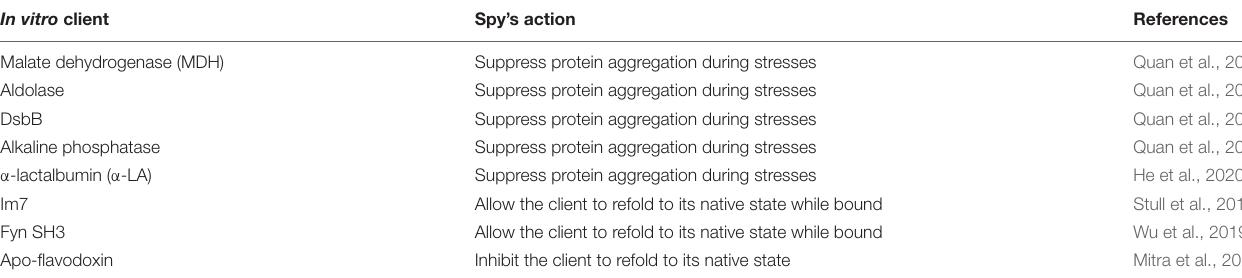
TABLE 1 | Various chaperone actions and mechanisms of